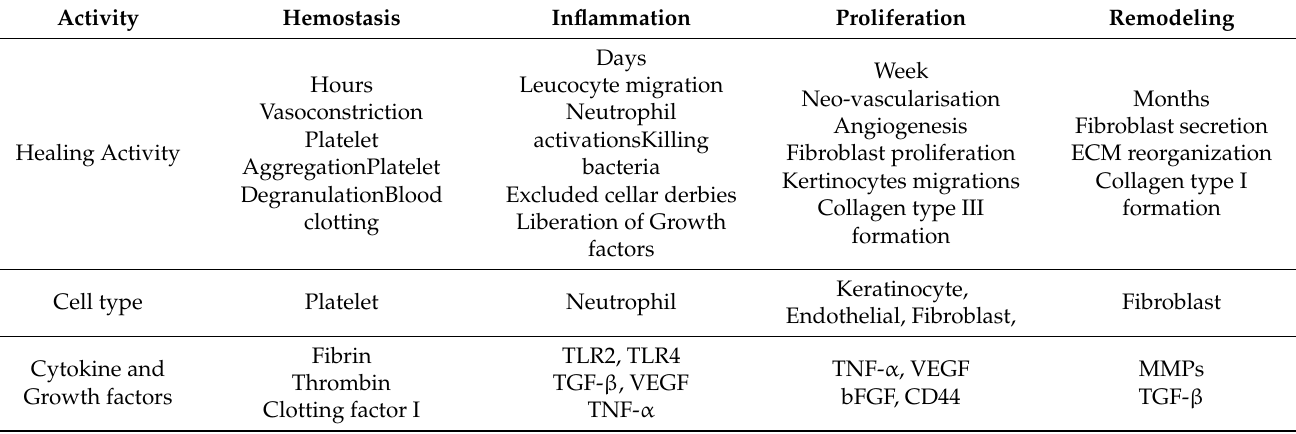
Table 1. A Summary of Wound